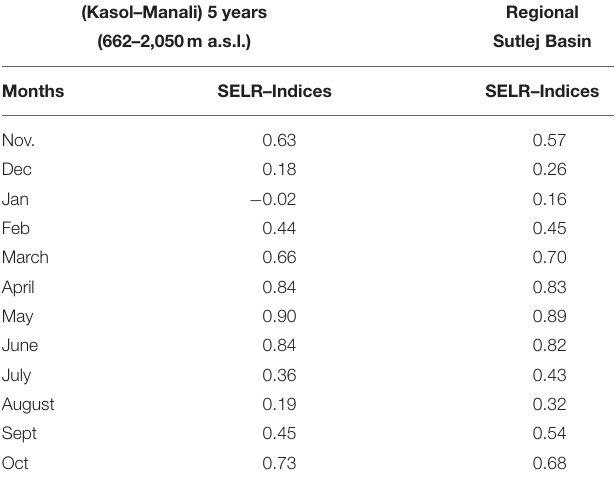
TABLE 2 | Comparison between monthly SELR indices ( Mi ) derived from Kasol (662m a.s.l.) to Manali (2050m a.s.l.) section using monthly mean temperature data of 1986–1990 period and regional indices derived through 5-fold cross validation of Kasol–Manali and Kasol–Rakcham data 1986–2000/2005 period.